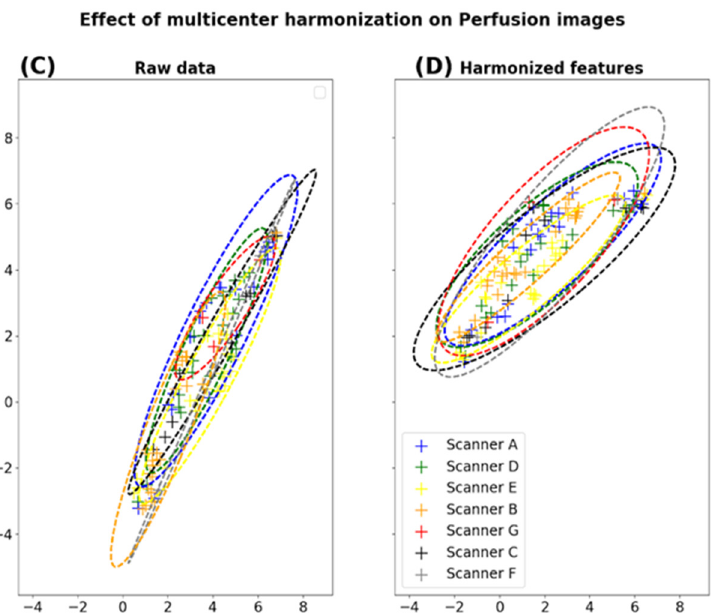
Figure 4. Dimension reduction of radiomic features extracted from the healthy ROIs on T1w and perfusion images. For each modality, a UMAP clustering is performed on raw data ( A , C ) and after harmonization ( B , D ).